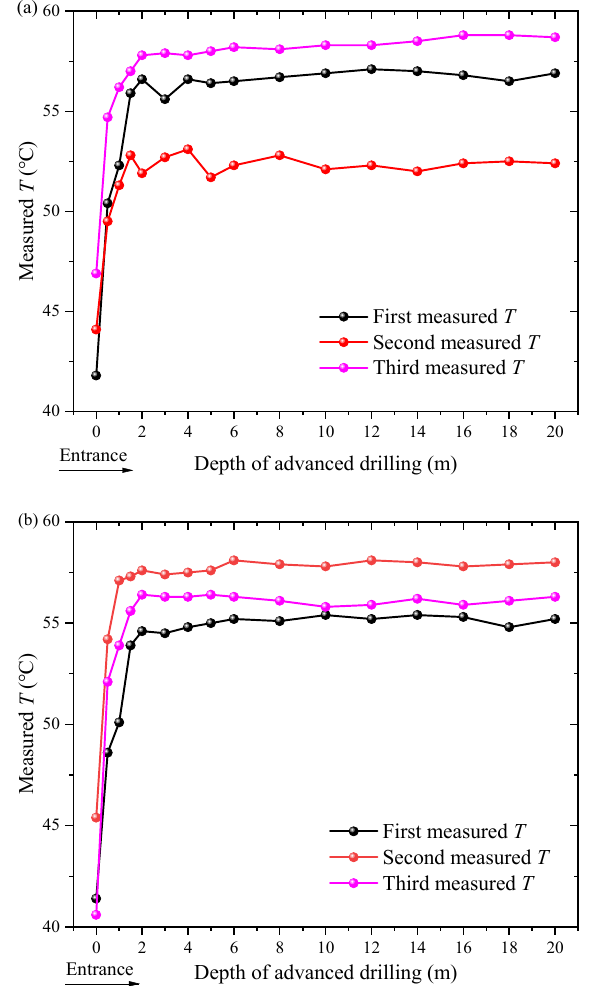
Figure 9. Matrix diagrams of the rock temperature change curve of three advanced drillings, in which T is the abbreviation for temperature: ( a ) left tunnel; ( b ) right tunnel.